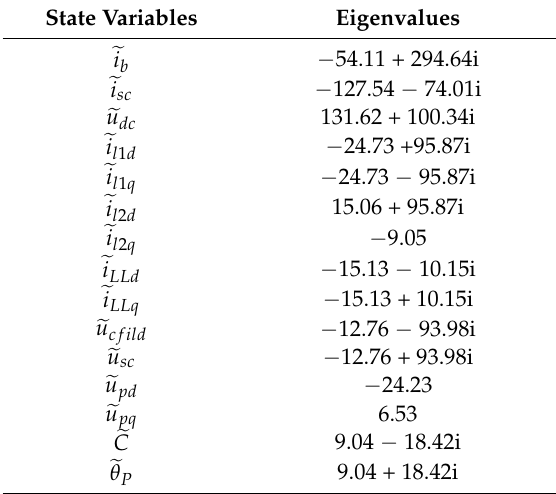
Table 6. Eigenvalues of micro-grid’s state matrix for (cid:1829) (cid:3046)(cid:3030) = 0.1 .